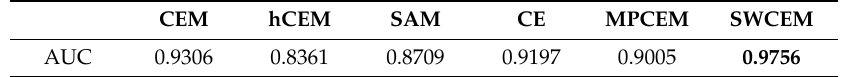
Table 3. The area surrounded by ROC curves of different algorithms on the Chanba Area data.